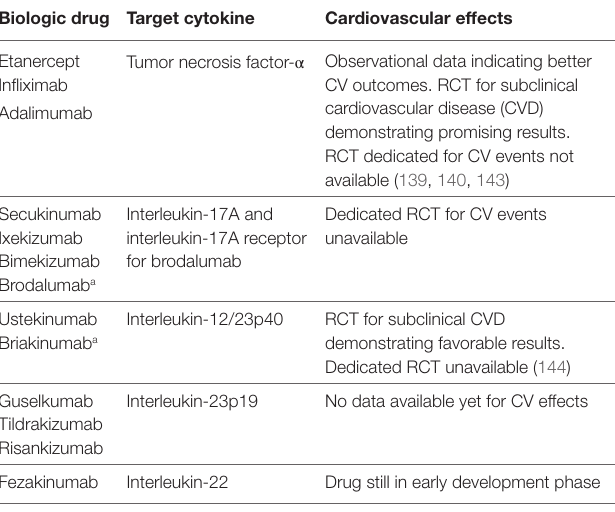
TABLe 1 | Biologic treatment options to treat